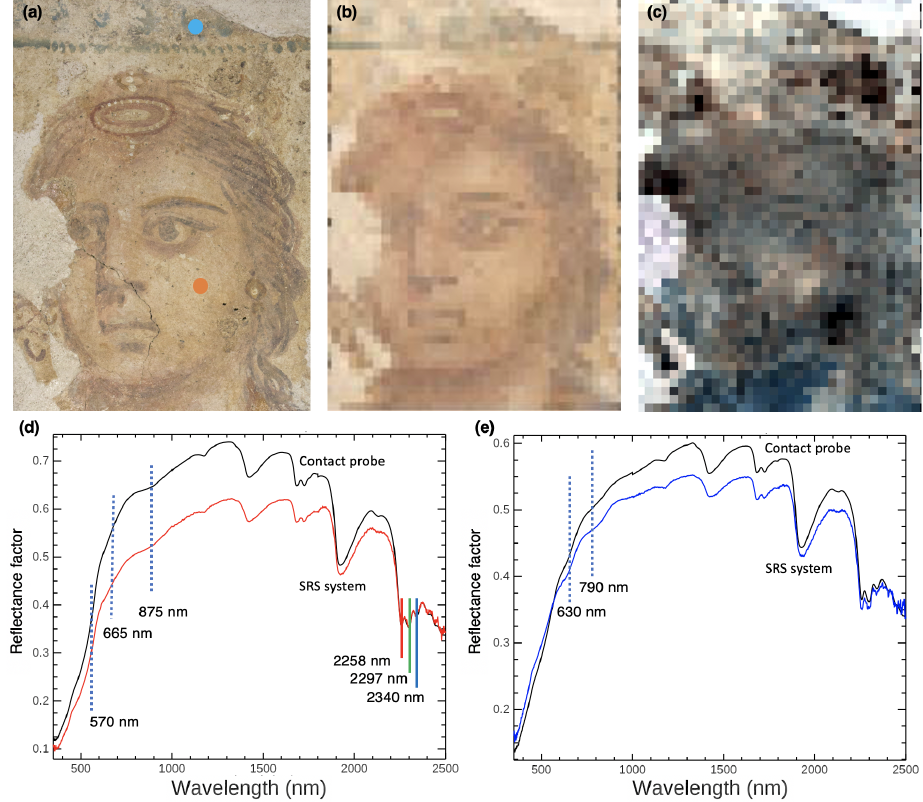
Figure 5. ( a ) Color photograph of the face in Painting of a woman (192 mm × 141 mm). ( b ) Recon- structed accurate color image from the reflectance image cube. ( c ) False-color SWIR image with blue, red, and green bands at 2258, 2297, and 2340 nm, respectively (these bands are marked in ( d )). ( d , e ) Full-range SRS hyperspectral system spectra (350 to 2500 nm) from select pixels (locations marked in ( a )) compared with FORS contact probe measurements at the same location. Characteristic absorptions and inflection points are marked by the dashed lines. ( d ) shows reflectance spectra from the flesh tone (red dot) in the figure’s proper left cheek (red—SRS system, black—contact probe), which have spectral features of red ochre in the VNIR spectral range (570, 665 and 875 nm). Spectra in ( e ) are reflectance spectra from the aedicula (blue dot) featuring Egyptian blue (blue—SRS system, black—contact probe), identified by absorptions at 630 and 790